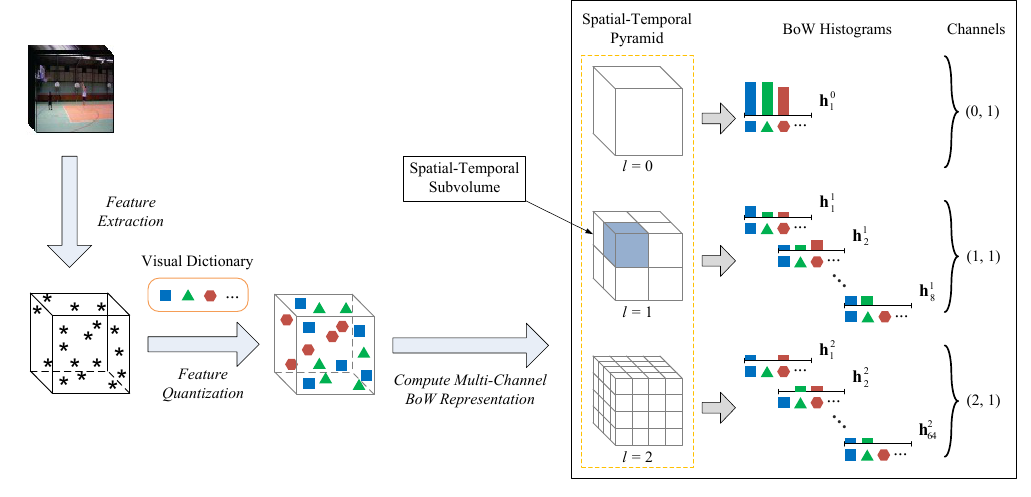
Figure 2. Illustration of building the multi-channel bag of words (BoW) representation for a video clip. In this figure, the local feature points are represented by black stars, and the quantized features are shown with geometrical shape symbols in different colors (e.g., blue square, green triangle and red hexagon), each type of which indicates one visual word. A three-level spatial-temporal pyramid ( i.e. , L = 2 ) is adopted for demonstration. For clarity, we show the case of using only one feature descriptor type ( i.e. , Q = 1 ) as an example. For the case of multiple feature descriptor types used, the BoW histograms for the channels of each individual feature type can be computed in a similar way. (Note: the image is best viewed in color with